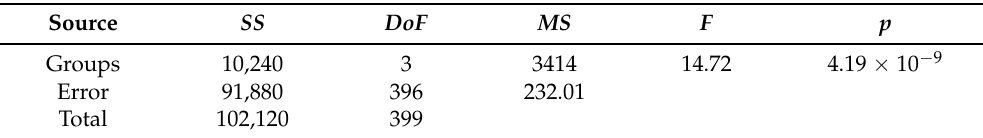
Figure 10. The GUI of SLASSY with the different steps to start the self-learning process. Table 5. ANOVA table for the compared performance vectors. Since the derived p -value (4.19 × 10 − 9 ) is smaller than the significance level (0.05), the differences are statistically